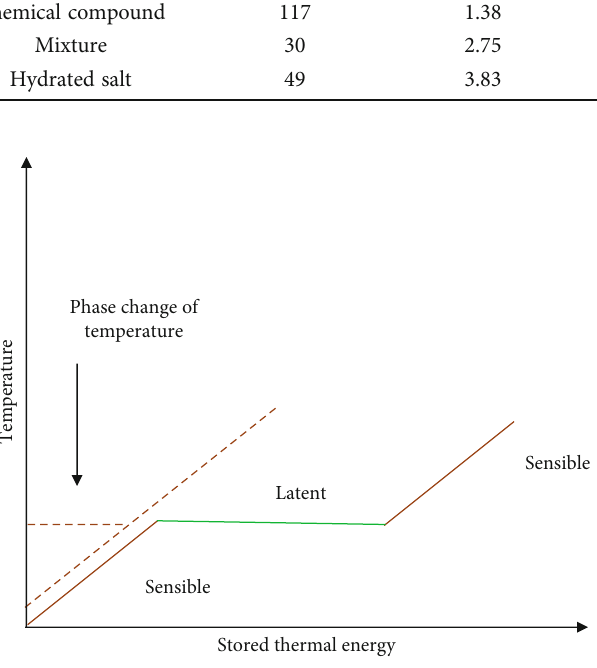
Figure 2: Measurement of increased thermal energy.